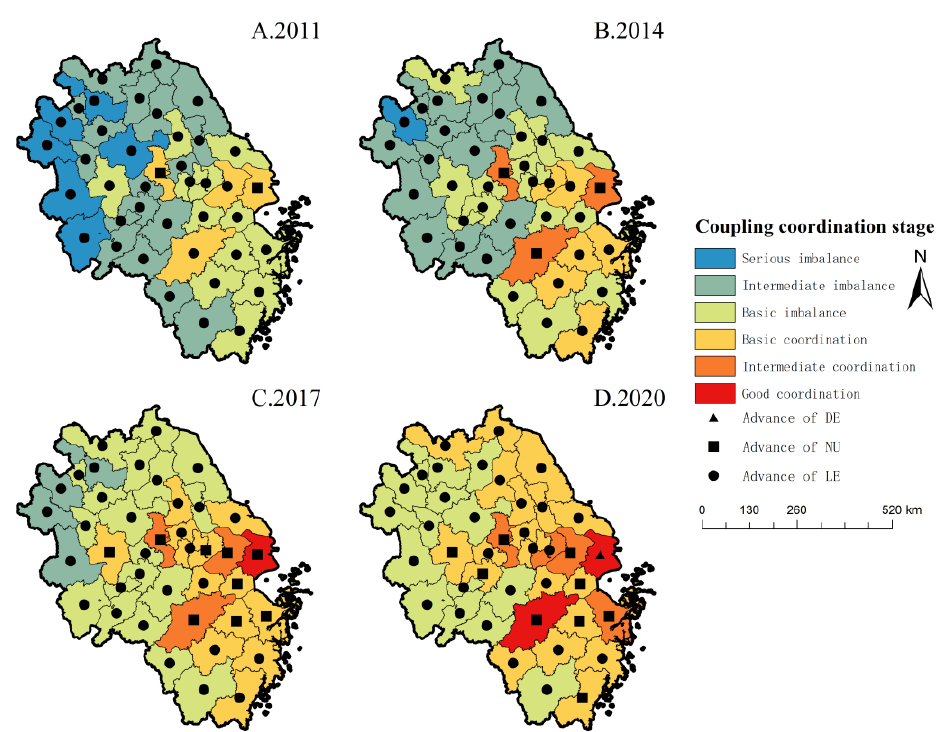
Figure 5. Spatial evolution characteristics of the coupling coordination degree.(Subfigure A presents the change of the coupling coordination degree in 2011. Subfigure B presents the change of the coupling coordination degree in 2014. Subfigure C presents the change of the coupling coordination degree in 2017. Subfigure D presents the change of the coupling coordination degree in 2020.)